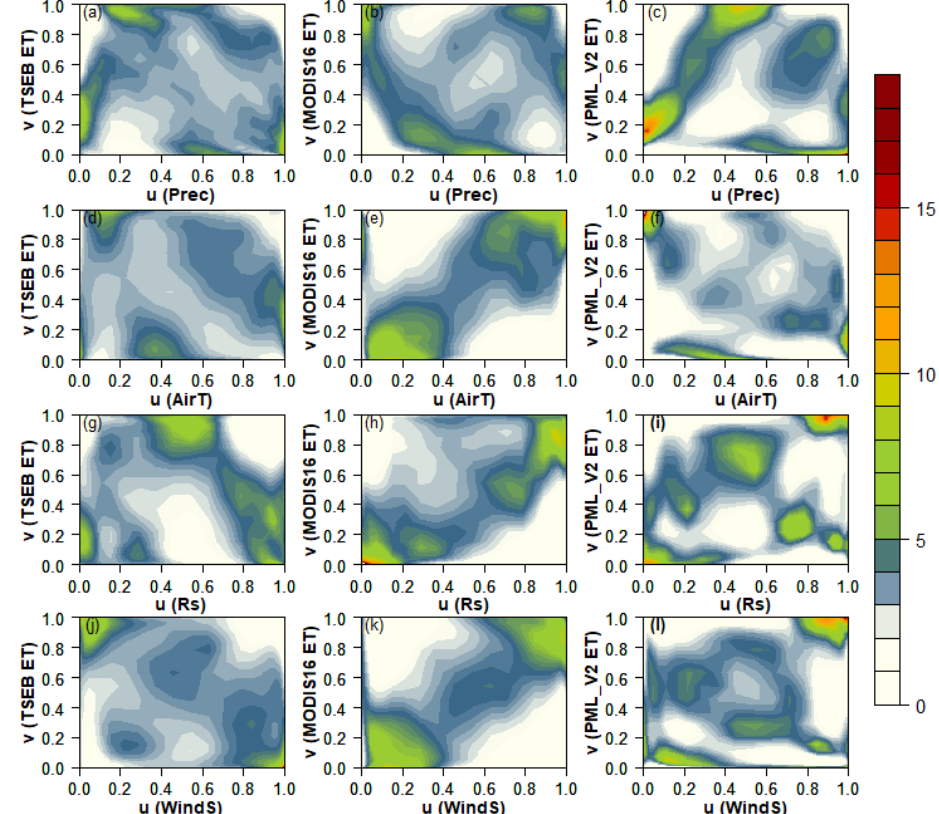
Figure A3. Grid-based empirical Copula densities between the remote-sensing ET datasets (TSEB ET: left panels, MODIS16 ET: middle panels, and PML_V2 ET: right panels) and meteorological variables of precipitation Prec, air temperature AirT, global shortwave solar radiation Rs, and wind speed WindS. The sample size is 19,712 data tuples for all the variables. In all the panels ( a – l ), remote sensing ET (y-axis) are plotted against meteorological variables (x-axis).